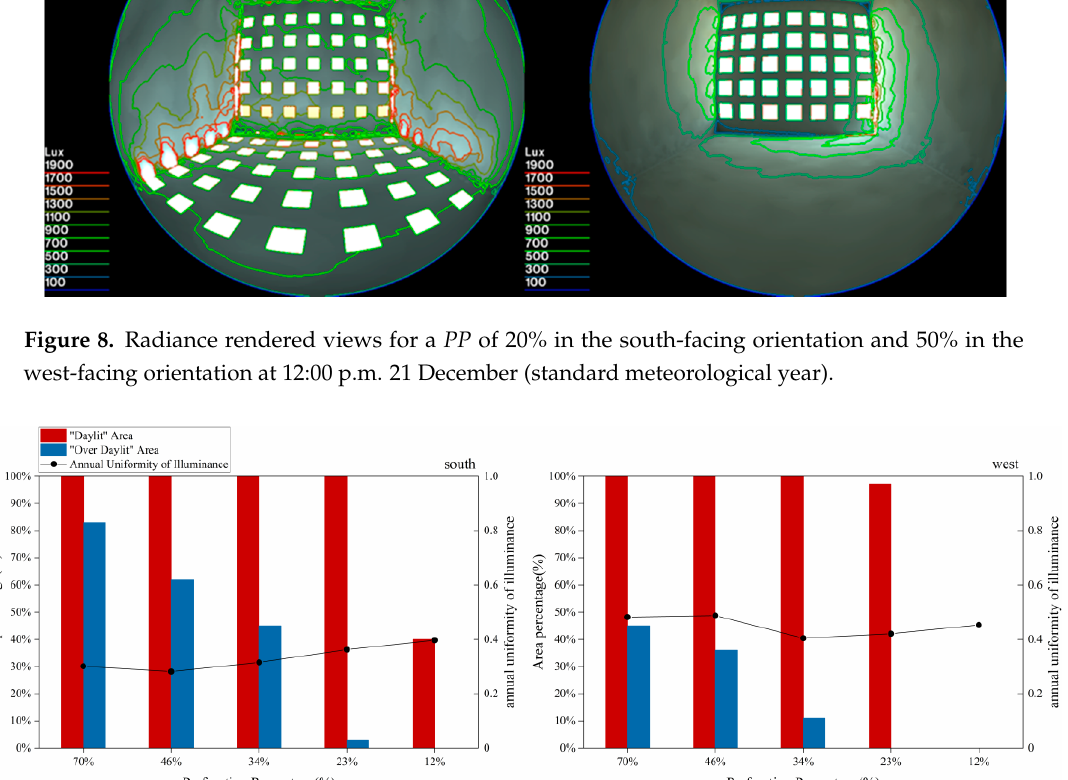
Figure 9. Daylighting and shading performance for the tested cases in Group 2.